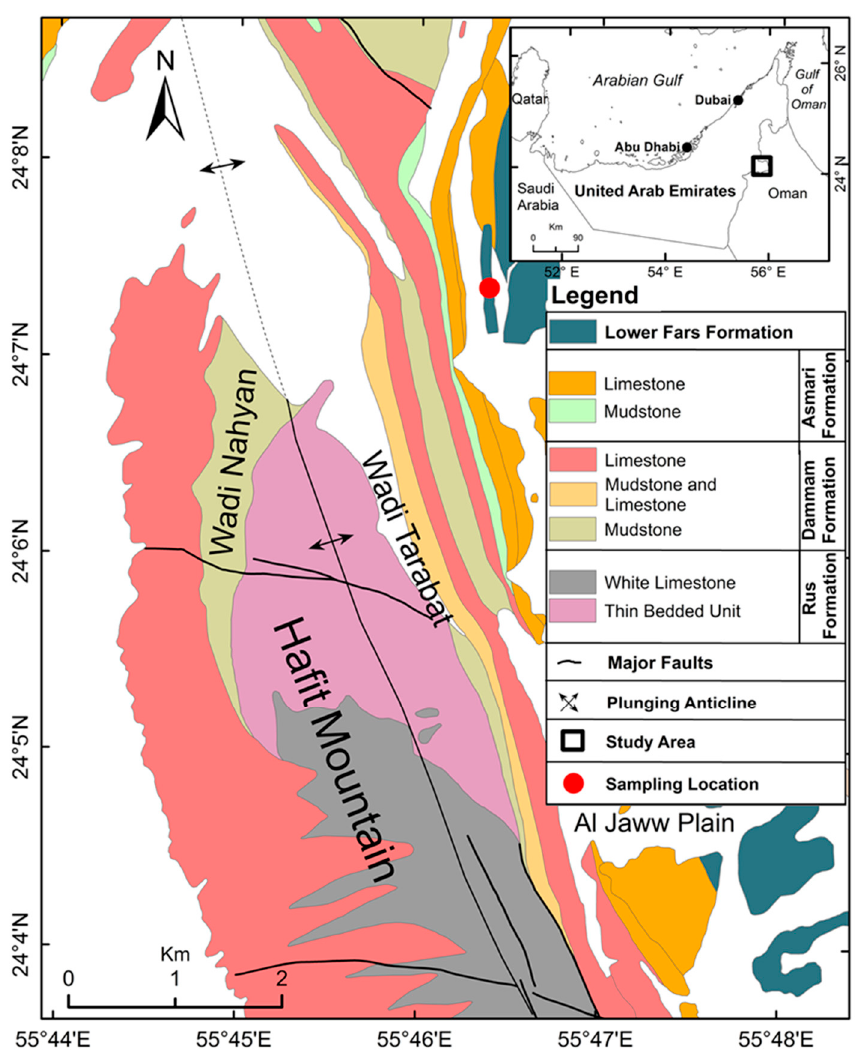
Figure 1. Geological map of the study area and sampling location [4].